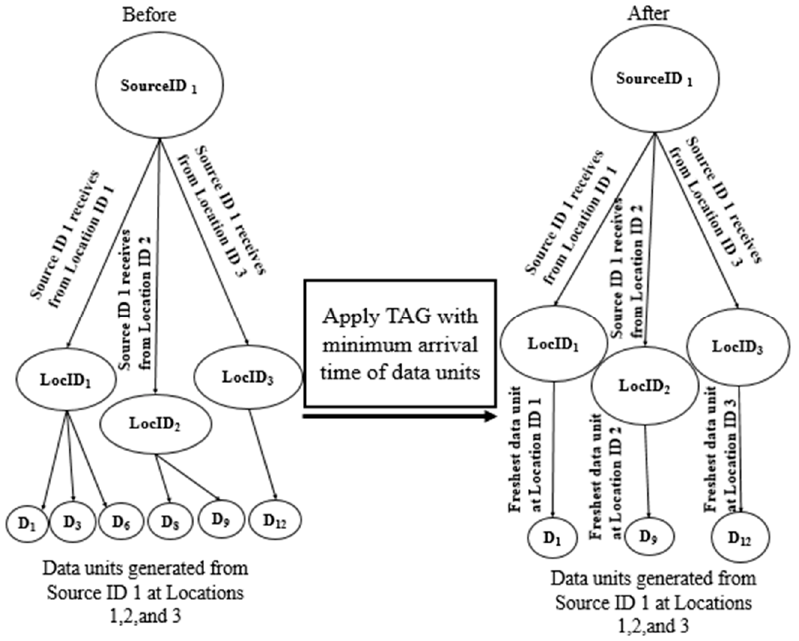
Figure 4. The TAG data aggregation technique in STDF.